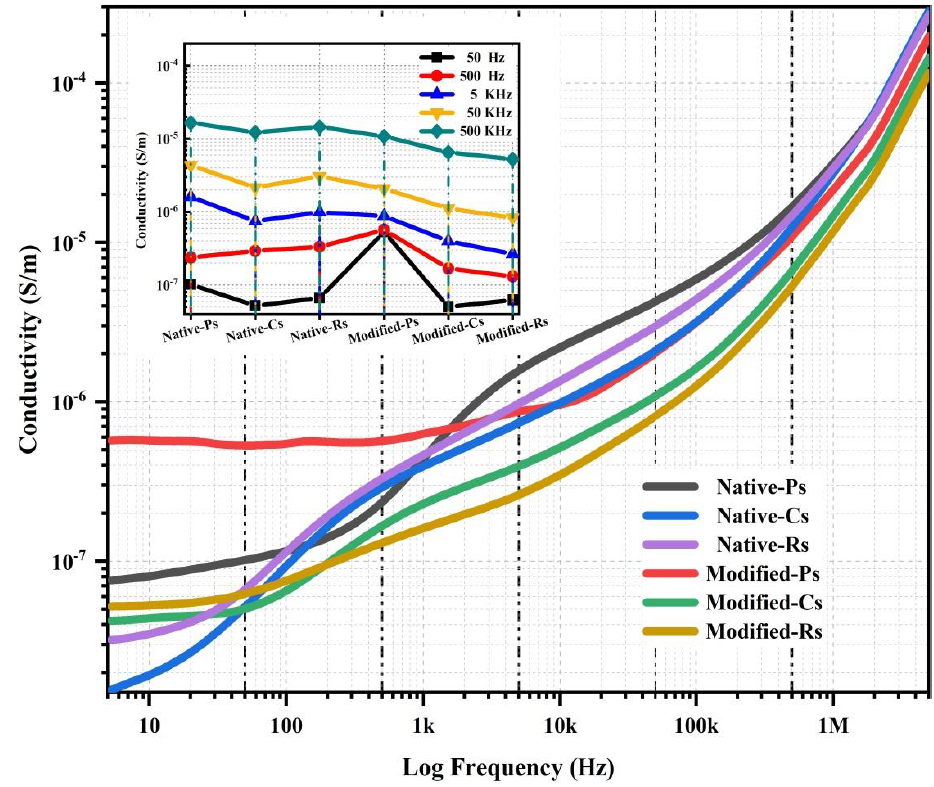
Figure 7. Frequency dependence of σ of native form and modified form of starches over the frequency range of 5 Hz–5 MHz.